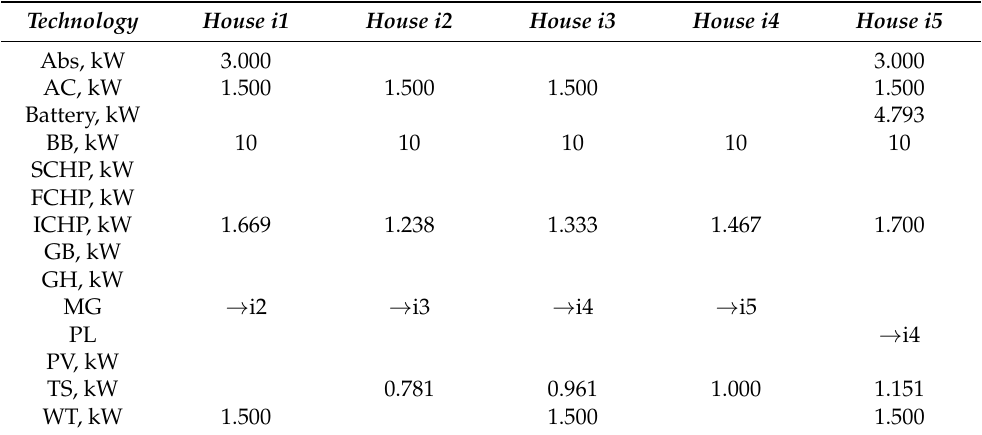
Table 11. Integrated DER technologies installations for the grid connected battery network with dynamic export pricing.